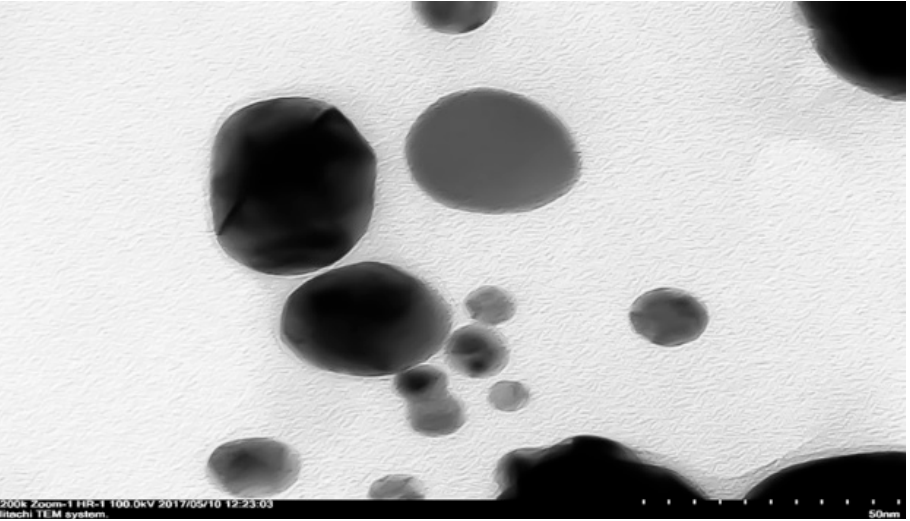
Figure 3. Infrared spectra of curcumin (red line) and curcumin-gold nanoparticle (black line). The morphology and particle size of curcumin-gold nanoparticles was analyzed by using cryo-Transmission Electron Morphology (cryo-TEM). cAuNPs had predominantly spherical particles and their size corresponded to the desired particle size range from 50 to 200 nm (Figure 4). This result was in line with the particle size of cAuNPs that were measured while using particle size analyzer (Table 1).